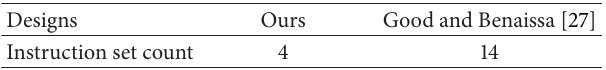
Table 9: Comparisons with other small AES